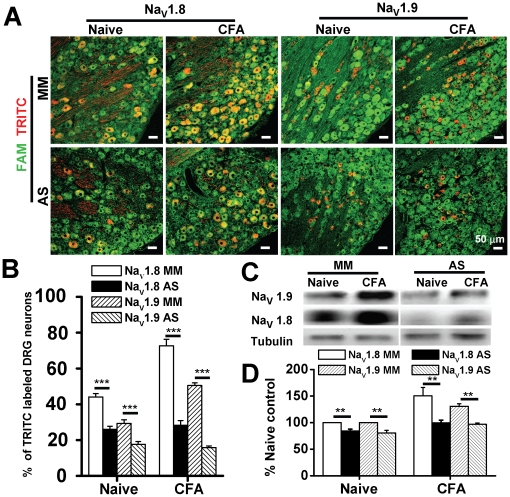
Down-regulation of NaV1.8 and NaV1.9 expressions in rat DRG neurons by antisense oligodeoxynucleotides (AS ODNs).(A) Examples of double immunofluorescent micrographs of DRG neurons from naive and CFA inflammation. FAM-labeled ODNs (green) were observed primarily in the cytoplasm in nearly all cell bodies of DRG neurons 3 days after i.t. administration of ODNs. (B) The percentage of TRITC-positive stains (NaV1.8 or NaV1.9) to the total number of FAM-labeled DRG neurons was significantly decreased by AS ODN in both naive and CFA-treated rats (n = 8). (C) Representative western blotting of NaV1.8 and NaV1.9 in DRG neurons from naive and CFA-inflamed rats following i.t. administration of ODNs. (D) Averaged percent changes in the amount of NaV1.8 or NaV1.9 protein level in DRGs of naive and CFA-treated rats (n = 5). CFA, complete Freund's adjuvant. AS, antisense. MM, mismatch. ODN, oligodeoxynucleotide. FAM, carboxyfluorescein. TRITC, tetramethylrhodamine-5-(and-6)-isothiocyanate. **p<0.01; ***p<0.001.